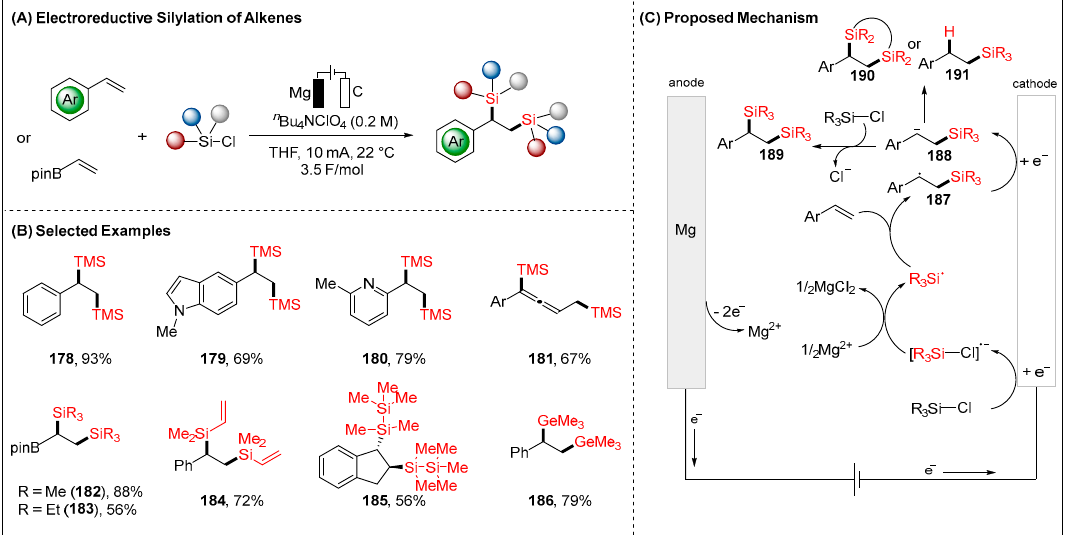
Figure 21. Electroreductive silylation of alkenes by Lin group.